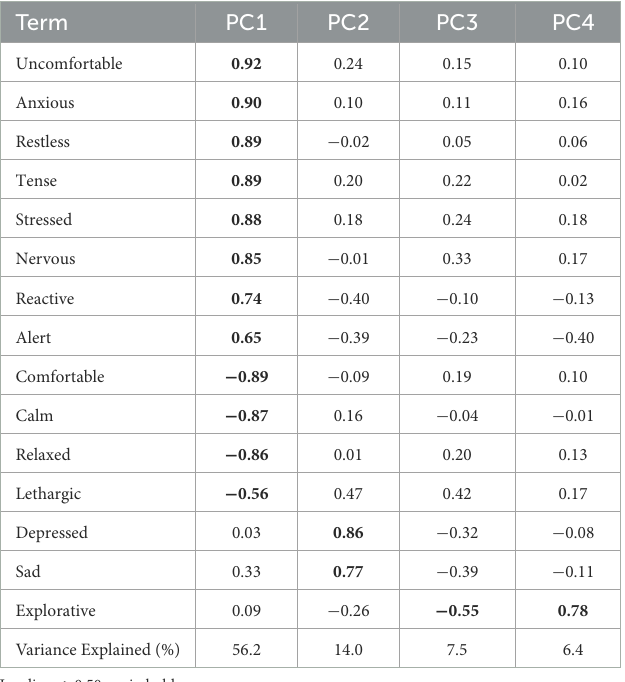
TABLE 3 Components extracted by the PCA of QBA